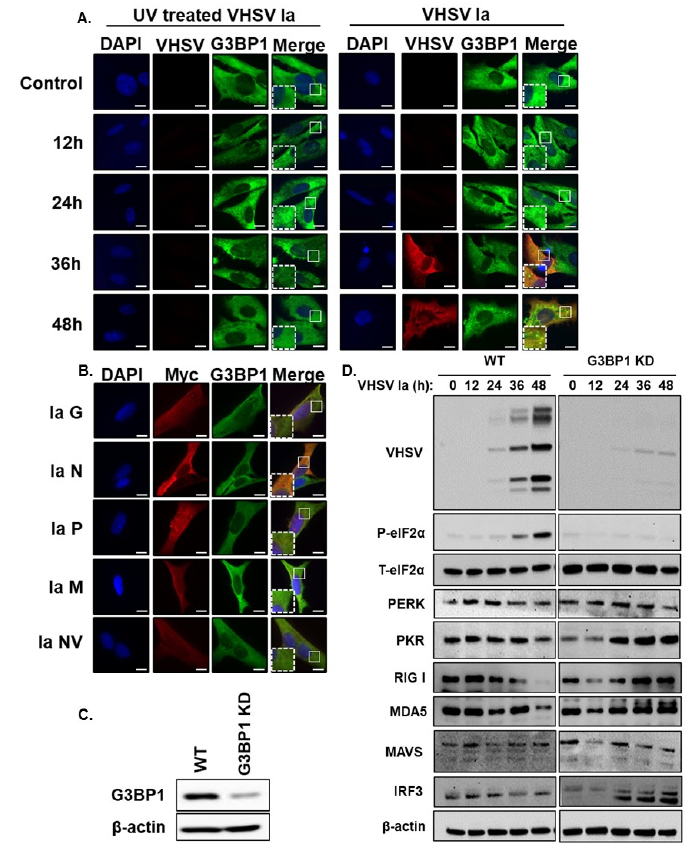
Figure 5. Viral replication is required for SG formation. ( A ) RTgill cells were infected with UV-inactivated or active VHSV Ia virus (MOI = 1) and after 48 h formation of stress granules was analyzed by staining with antibodies against G3BP1 and VHSV, ( B ) RTgill cells were transfected with myc-tagged plasmids for indicated VHSV proteins for 48 h and stress granule formation was analyzed by staining with antibodies against G3BP1 and myc, ( C ) CRISPR/Cas9 knockdown of G3BP1 in RTgill cells was verified by immunoblotting using G3BP1 antibody. β -actin was used as loading control. ( D ) WT and G3BP1KD cells were infected with VHSV Ia at MOI = 1 for indicated times. Cells lysates were separated and immunoblotted for indicated proteins. β -actin was used as loading control. Scale bar 1 μ m; WT: wildtype; KD: knockdown; data are representative of results from two independent experiments.